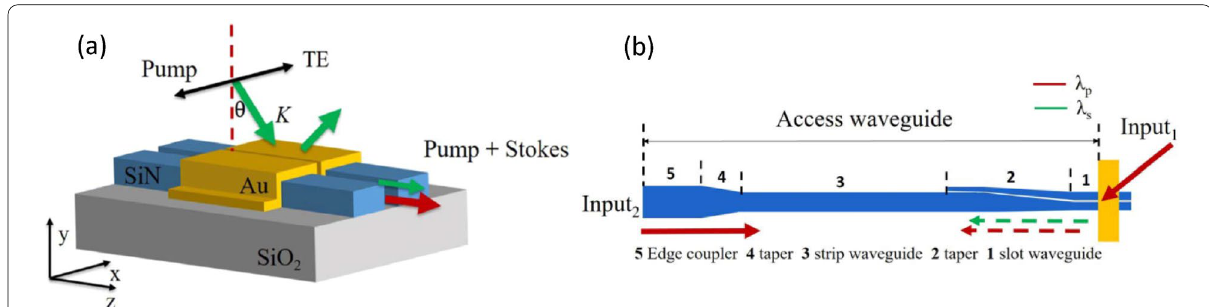
Fig. 16 a The schematic of plasmonic slot waveguide with oblique illumination in free space. The red dashed line is perpendicular to the top surface of the waveguide. The green and the red arrows indicate the propagation directions of the pump beam and Stokes beam respectively. b The Raman plasmonic sensor (yellow) complemented by a Si 3 N 4 mode converter between slot and strip waveguides, a strip waveguide and a taper for in/out coupling to free space. The red arrows for Input 1 indicates the out-of-plane pumping beam mode of the excitation, while Input 2 refers to the pump beam adopted in waveguide coupled mode for the comparison of noise suppression. In both cases the red and green colours refer to pump and Stokes beam respectively. Dashed arrows are the collected light. Adapted with permission from Ref [65], Copyright © 2020, IEEE